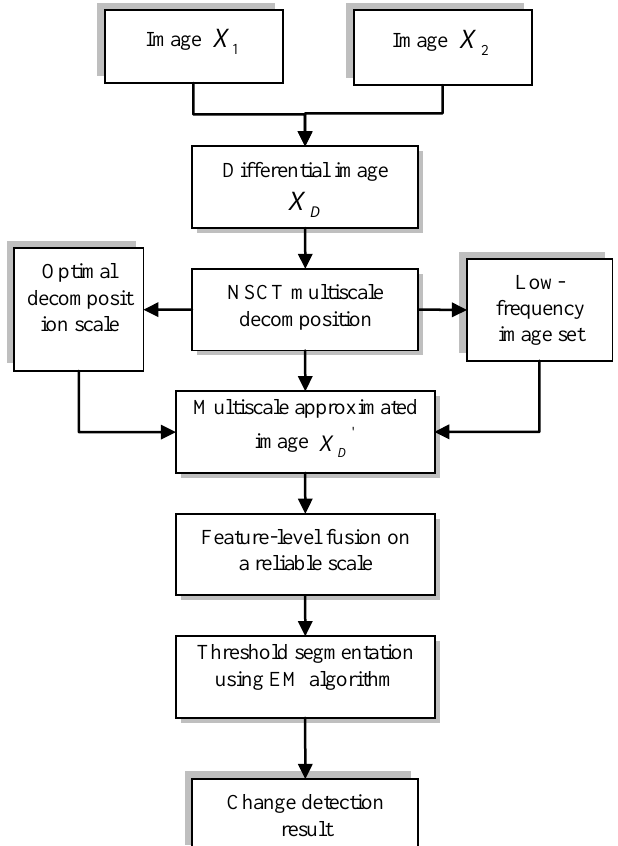
Figure 1. Change detection kernel operator based on